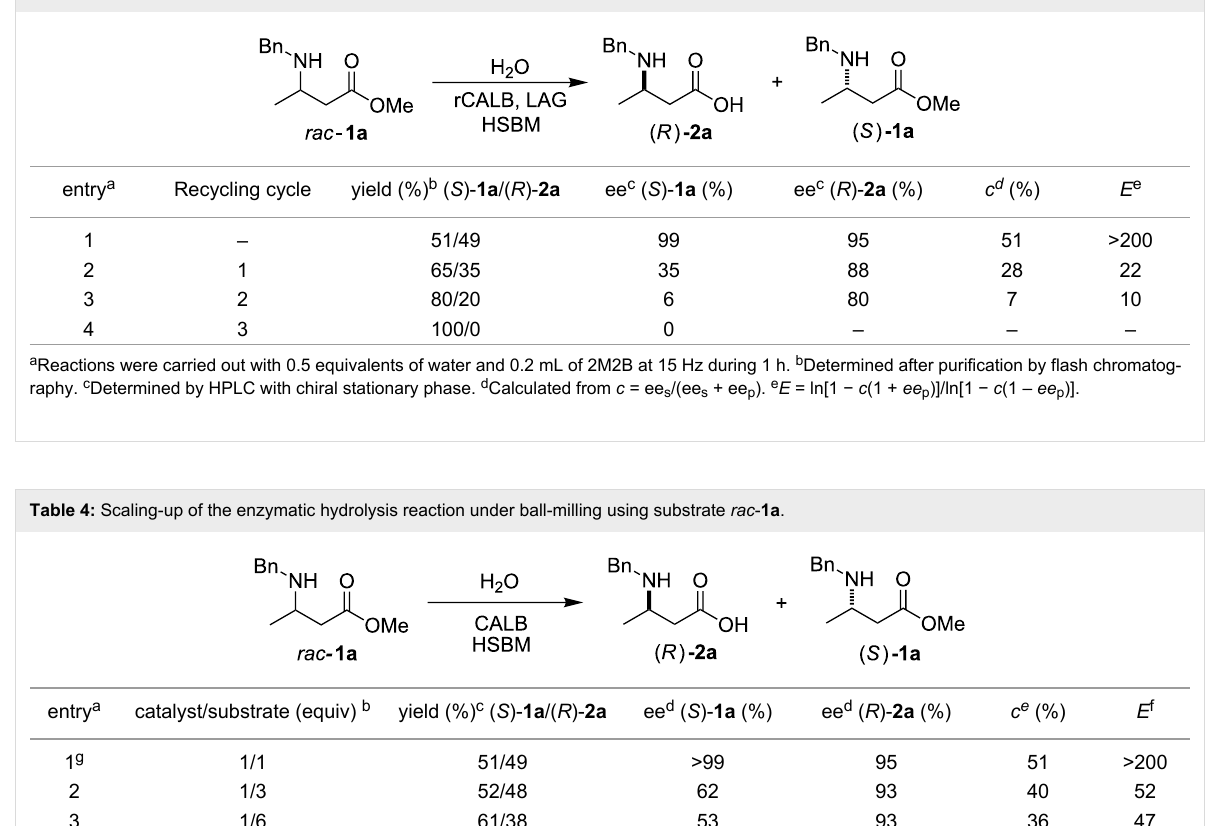
Table 3: Recycling capacity of immobilized CALB under HSBM conditions.